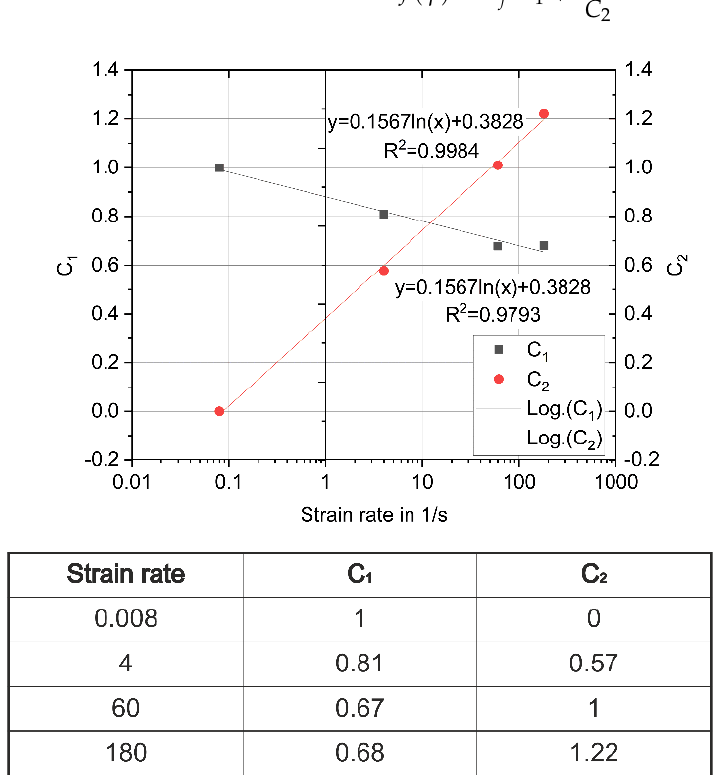
Figure 9. Logarithmic dependency of coefficients C 1 and C 2 on the strain rate.